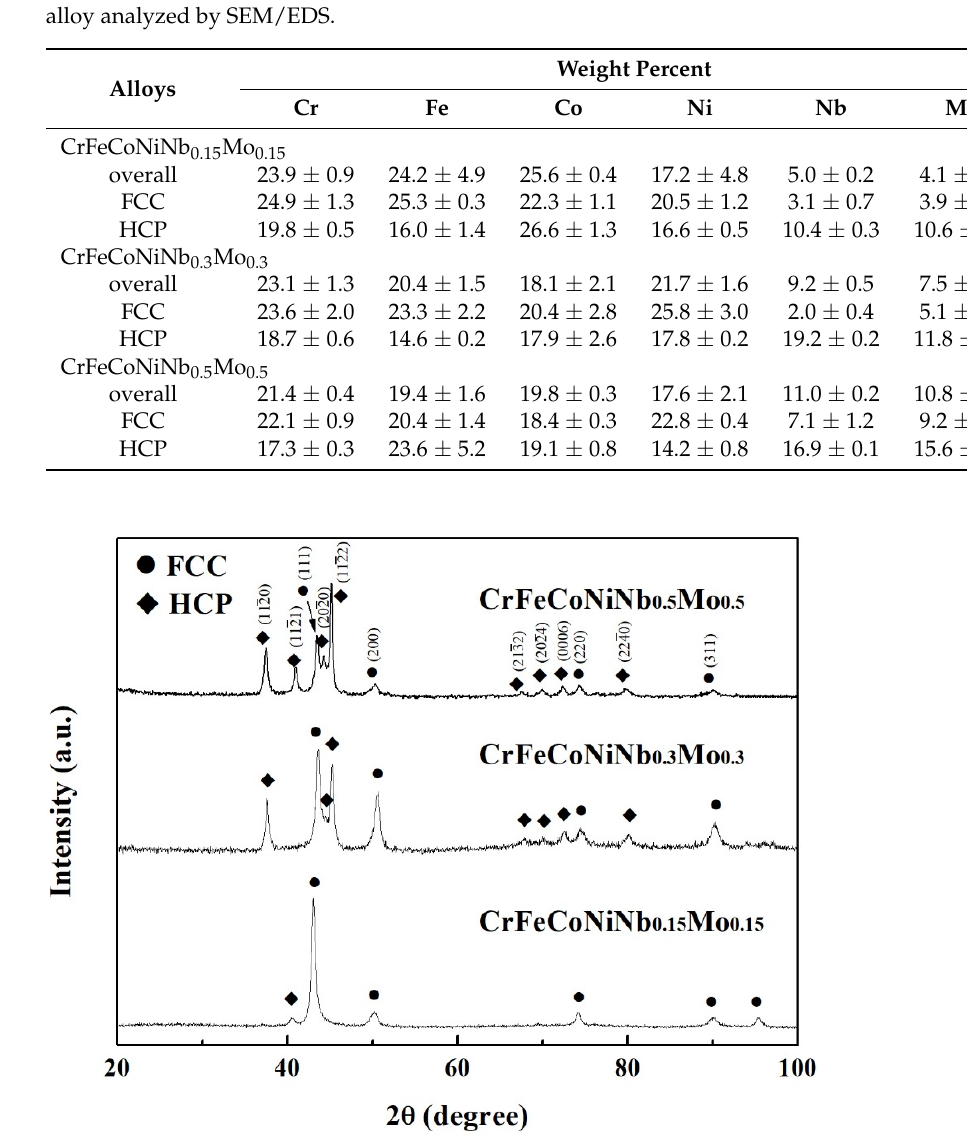
Figure 2. XRD patterns of as-cast CrFeCoNiNb x Mo x alloys.